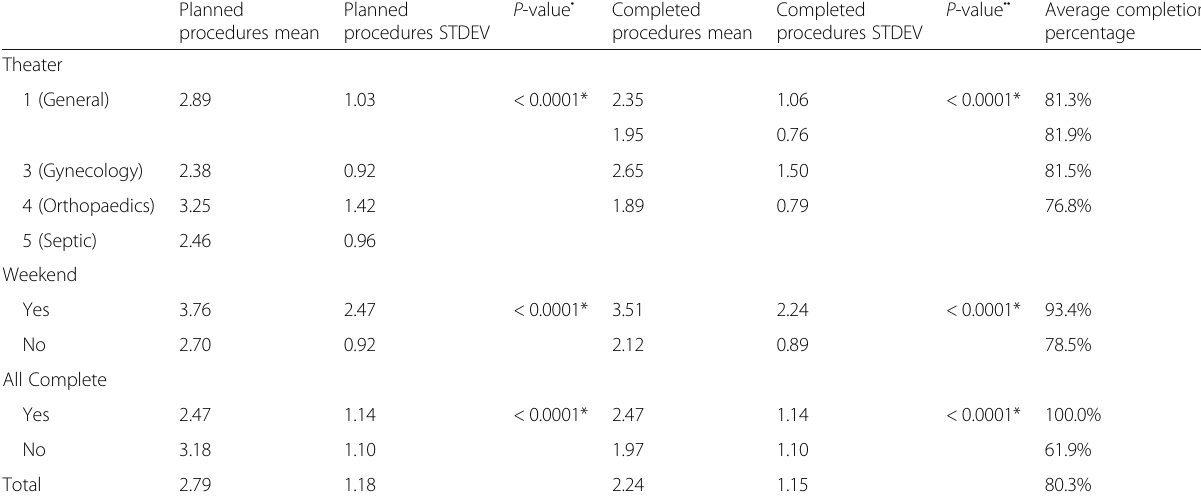
Table 4 Elective procedure volume planned vs. completion per operating day